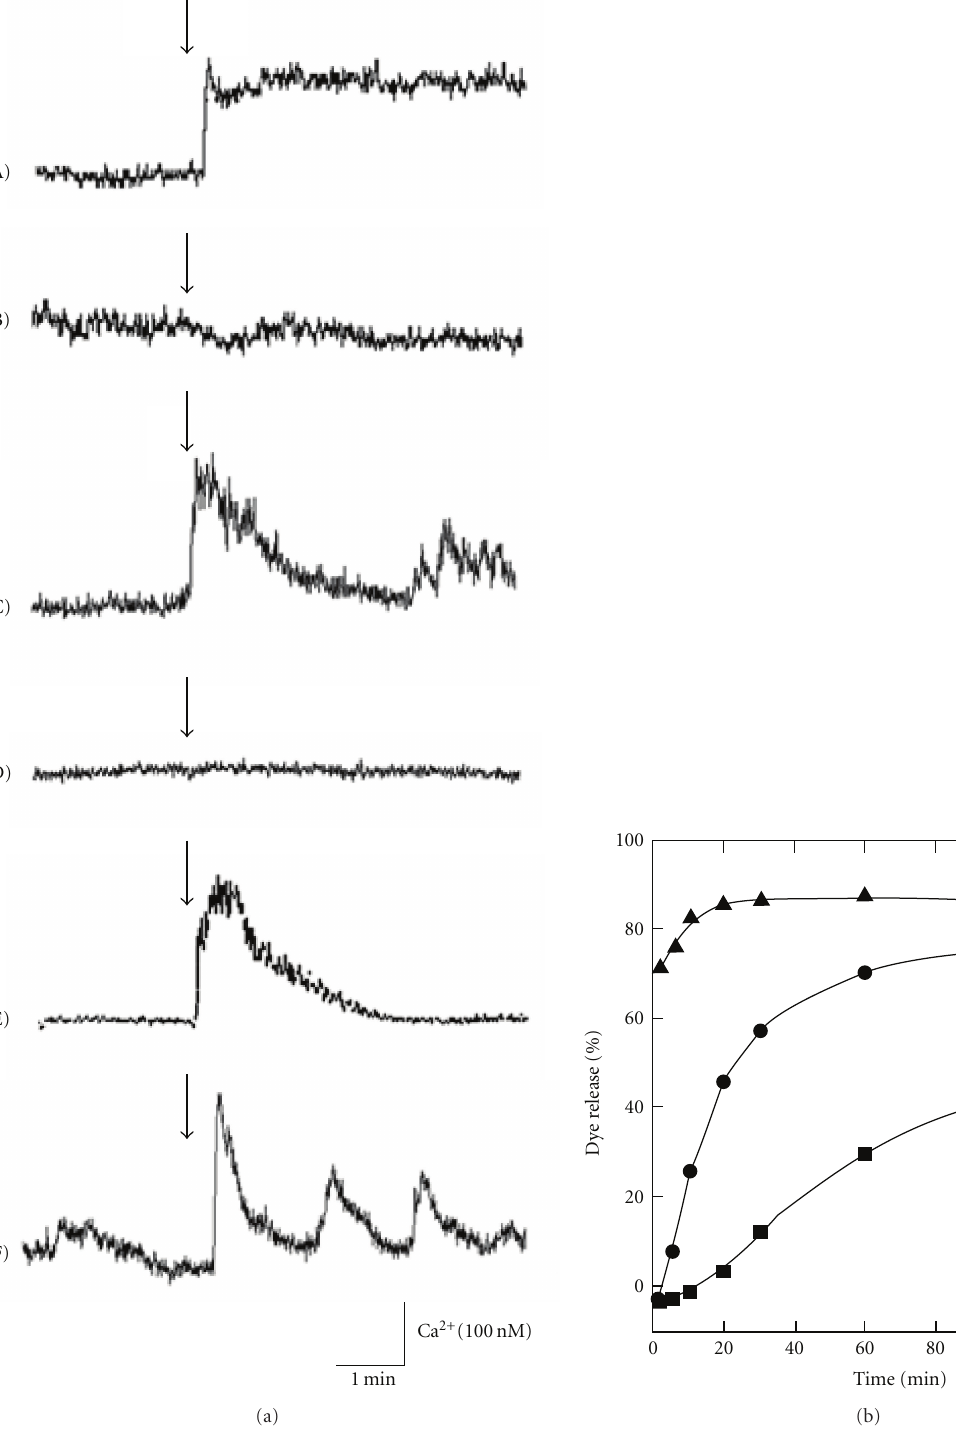
Figure 3: E ff ects of amyloidogenic proteins on membrane disruption and [Ca 2+ ] i elevations. (a) E ff ects of amyloidogenic proteins and their analogueson [Ca 2+ ] i . Typical time course of [Ca 2+ ] i prior to 2min and after 3 minof the application ofthe peptide is depicted. Concentration is 10 μ M for all peptides used. (A) PrP106–126; (B) scramble PrP106–126; (C) human amylin; (D) rat amylin; (E) NAC; (F) magainin 2. The arrow indicates the time of peptide addition. (b) Membrane disruption by amyloidogenic peptides. A β P(1–40) (closed circle), PrP106–126 (closed square), and human amylin (open circle) (each 10 μ M) were added to negatively charged liposomes containing carboxyfluorescein. The ratio of DPPC (dipalmitoil phosphatidyl choline) : CHOL (cholesterol) : DPPG (dipalmitoil phosphatidyl glycerol) in the liposome was 3:4 :3. The temporal changes of the fluorescence intensity were monitored. The ratio of the released fluorescent dye (carboxy fluoresein; CF) compared to the total amount of CF was described as the percentage of membrane